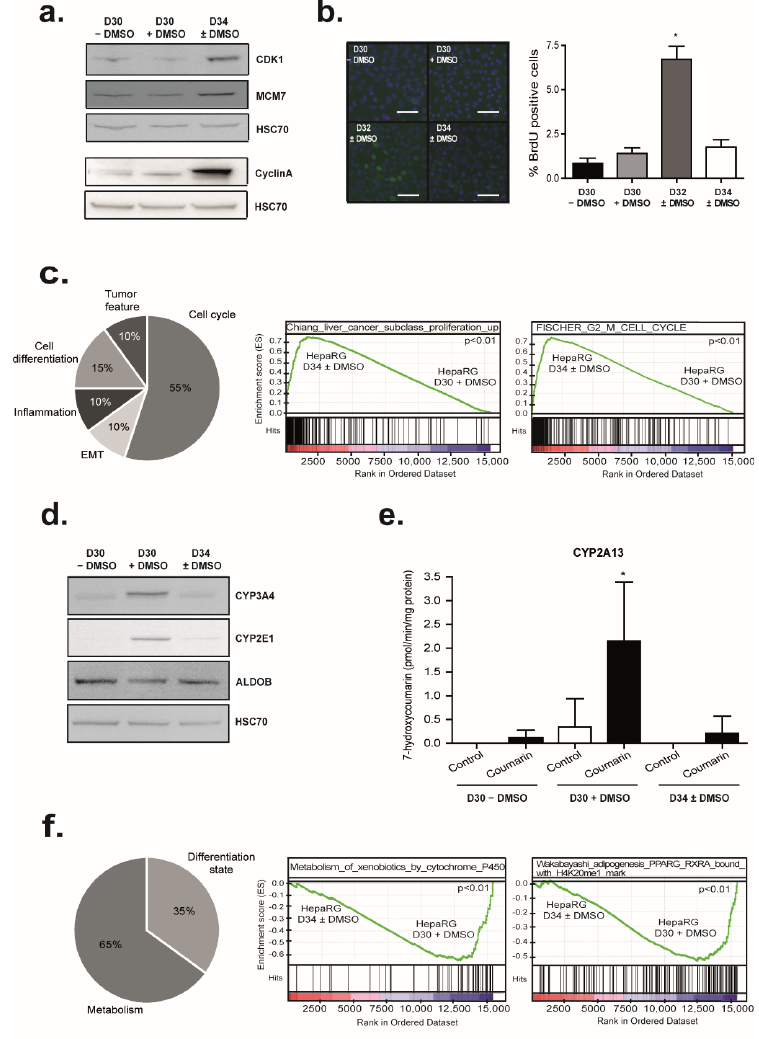
Figure 7. Transient cell cycle entry and modulation of metabolic functions of differentiated HepaRG cells after DMSO removal. ( a ) Effects of DMSO removal on the protein level of cell cycle-regulated genes (CDK1, MCM7, and CyclinA) were analyzed by Western blot (n = 3). HSC70 was measured as an internal control. ( b ) Transient induction of HepaRG cell proliferation after DMSO removal was analyzed by measuring BrdU incorporation (n = 3). Immunolocalization of HepaRG cells with anti-BrdU antibody. BrdU positive cells were shown in green, and nuclei were in blue (Hoechst). Scale bars = 50 µ m. Quantification of BrdU incorporation was performed by Cell Health Profiling BioApplication from Cellomics software. * p < 0.05. ( c ) GSEA analysis using the gene expression profiles of HepaRG at D30 + DMSO and HepaRG at D34 ± DMSO. Functional repartition of the top 20 significant signatures enriched after DMSO removal. GSEA revealed an enrichment of the “Chiang_liver_cancer_subclass_proliferation_up” signature and the “Stein_ESR1_targets” signa- ture. ( d ) Protein level of drug metabolism genes (CYP3A4, CYP2E1, and ALDOB) were analyzed by Western blot to confirm the gene expression changes after DMSO removal from the culture medium (n = 3). HSC70 was measured as an internal control. ( e ) Effect of DMSO removal on drug- metabolizing enzyme activities in HepaRG cells. HepaRG cells were incubated for 2 h with 200 µ M of coumarin to measure CYP2A13 activity. 7-hydroxylation of coumarin was estimated by HPLC (n = 3). * p < 0.05. ( f ) GSEA analysis using the gene expression profiles of HepaRG at D30 + DMSO and HepaRG at D34 ± DMSO. Functional repartition of the top 20 significant signatures lost after DMSO removal. GSEA revealed an enrichment of the “Metabolism_of_xenobiotics_by_cytochromes_P450” and the “Wakabayashi_adipogenesis_PPARG_RXRA_bound_with_H4K20me1_mark”